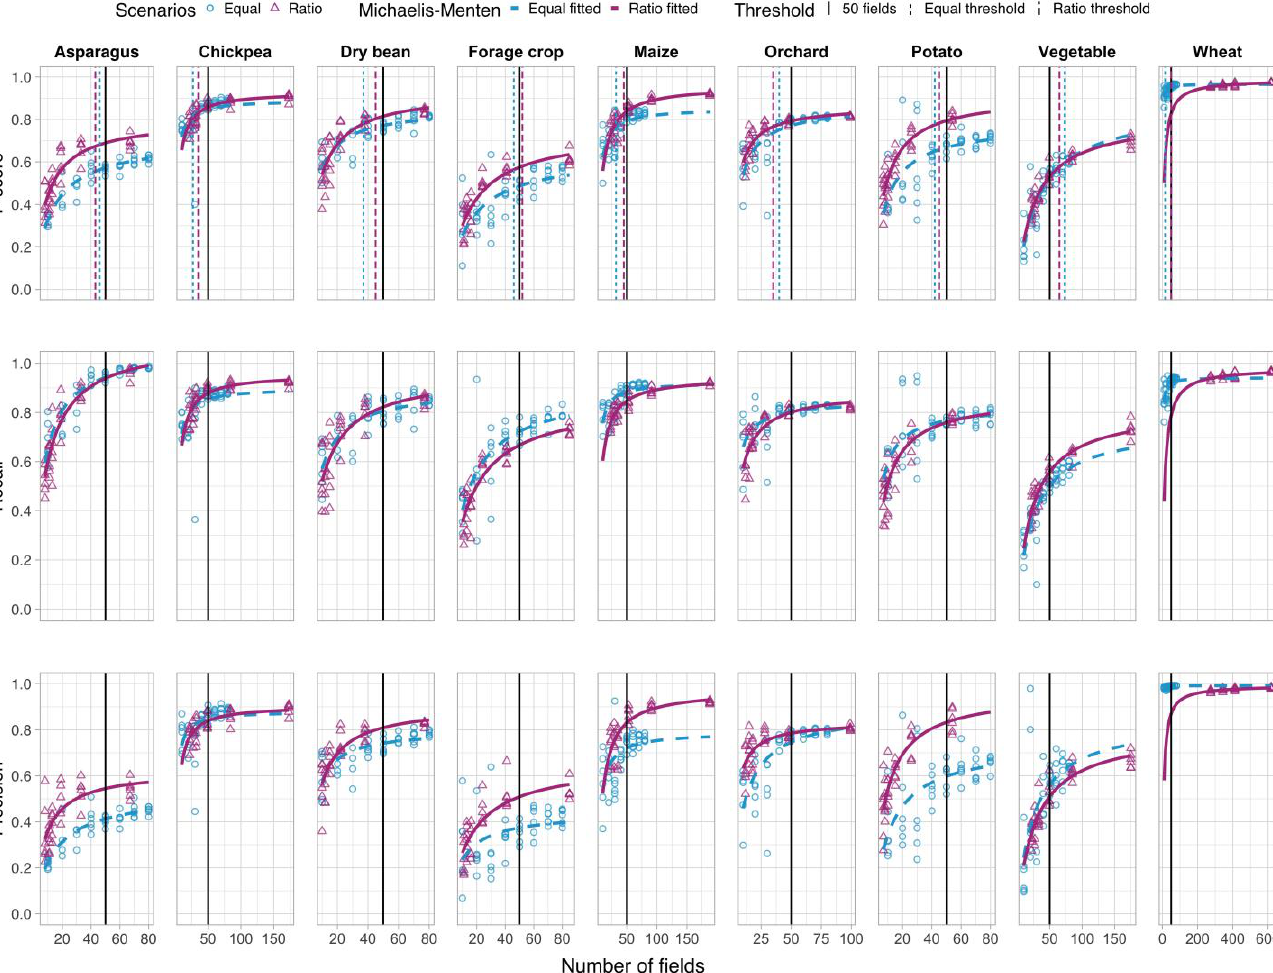
Figure 7. F-score, recall and precision of nine crop types as a function of number of fields and sam- pling strategy. Either a fixed or a proportionate number of fields of each crop type was selected for the training set. The respective scenarios are called Equal or Ratio. The solid vertical bar marks 50 fields. The number of fields at which the threshold of an increase in F-score by 2.5% for an additional ten fields was reached is also marked. All classification scenarios were run six times.